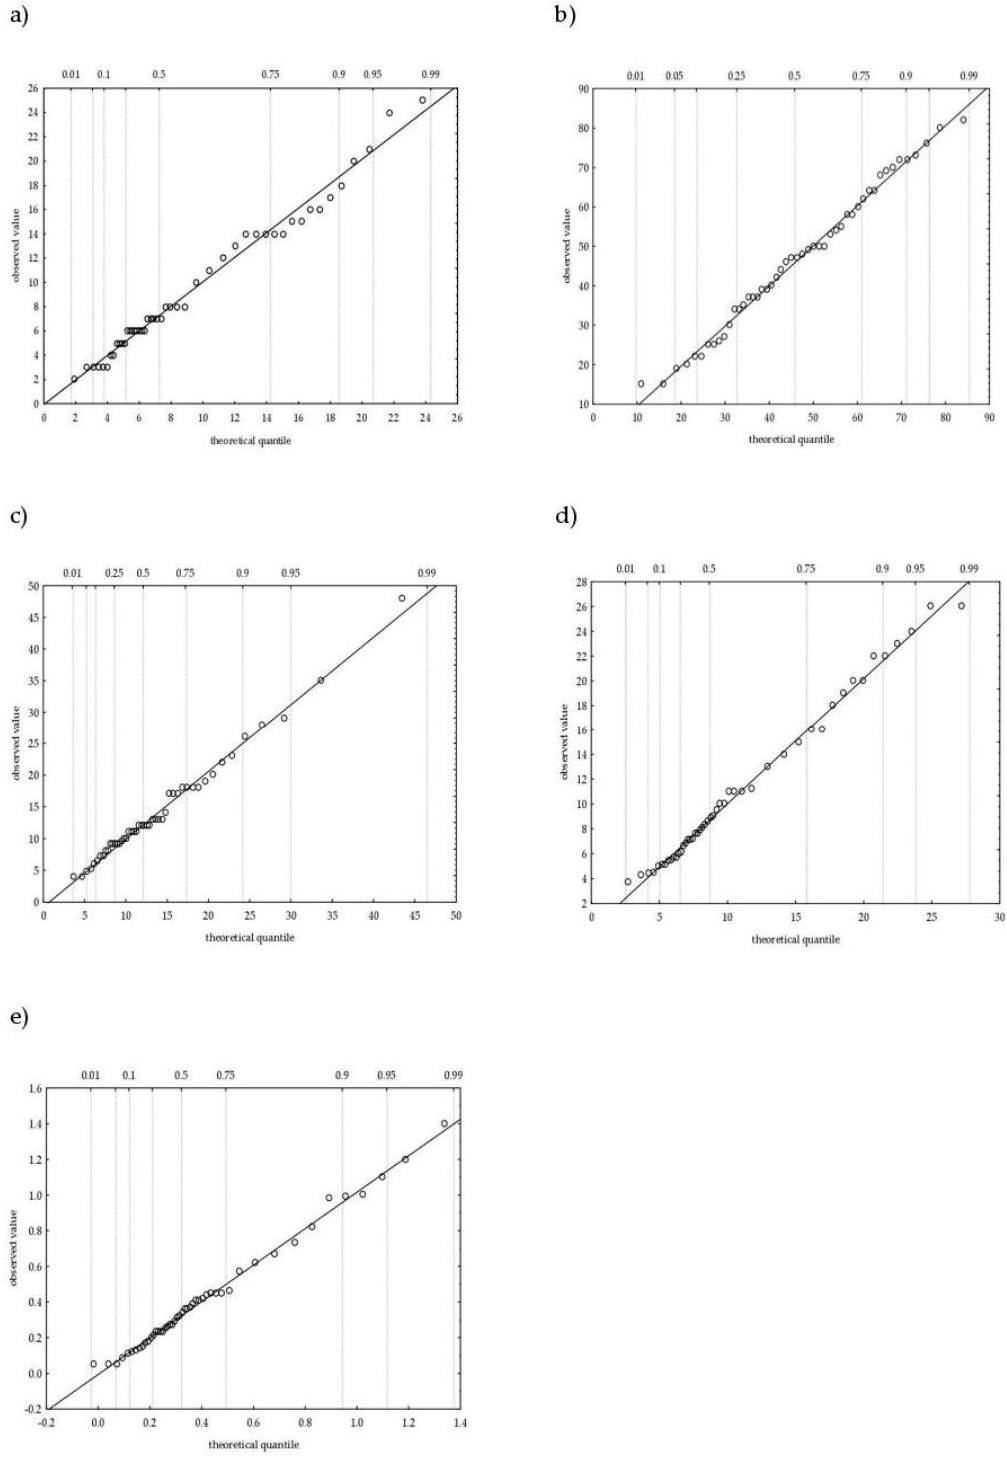
Figure 3. Quantile-quantile (Q-Q) graph type for the best-fitting random variables statistical distributions: ( a ) BOD 5 , ( b ) COD Cr , ( c ) Total Suspended Solids (SS t ), ( d ) Total Nitrogen (TN), and ( e ) Total Phosphorus (TP).